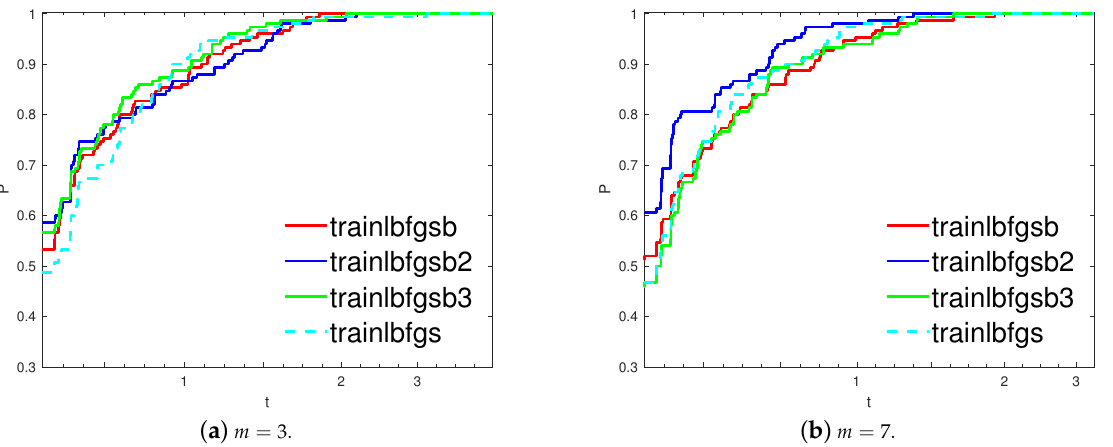
Figure 12. Log 10 scaled performance profiles based on F 1 -score for the SPECT heart classification